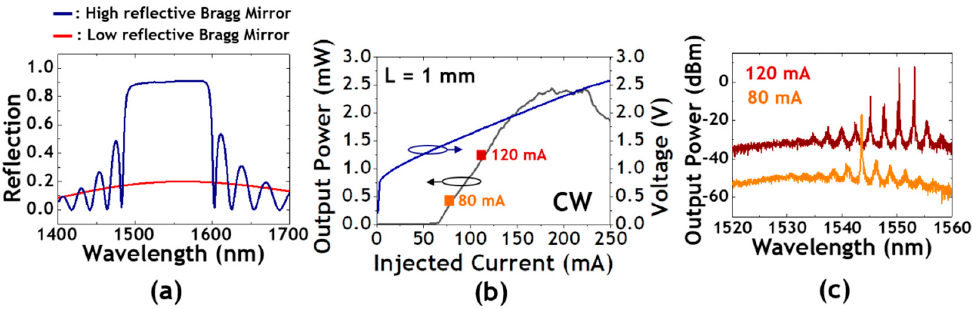
Figure 15. ( a ) Simulation of the reflection of the grating mirrors against wavelength with the high reflective mirror in blue and the low reflective mirror in red; ( b ) Waveguide-coupled output power against injected current measured under CW operation @20 °C; ( c ) Spectra measured @20 °C for 80 mA and 120 mA injected currents.